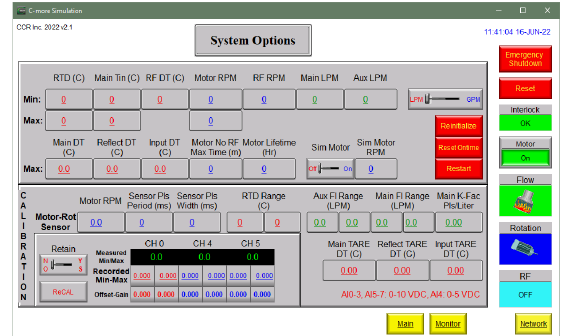
Fig. 16 . Sample PLC